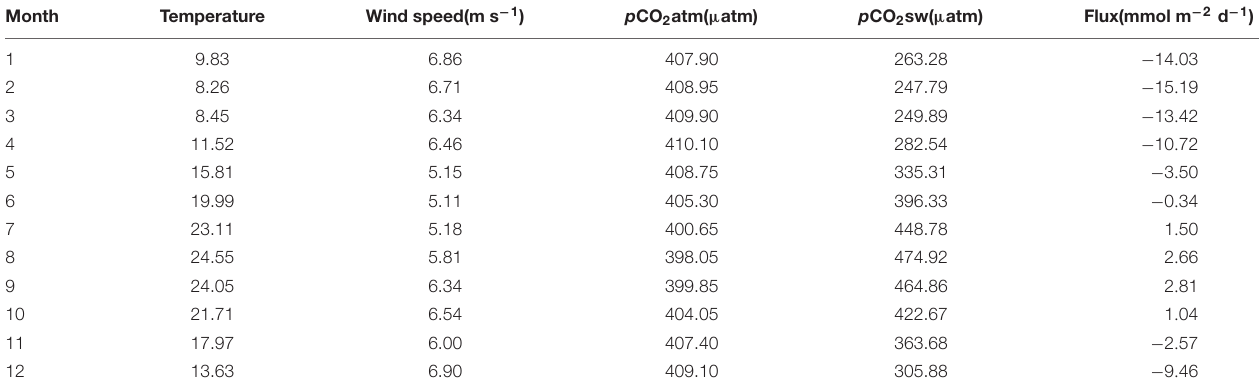
TABLE 2 | Monthly values of calculated air-sea CO 2 flux and related parameters.